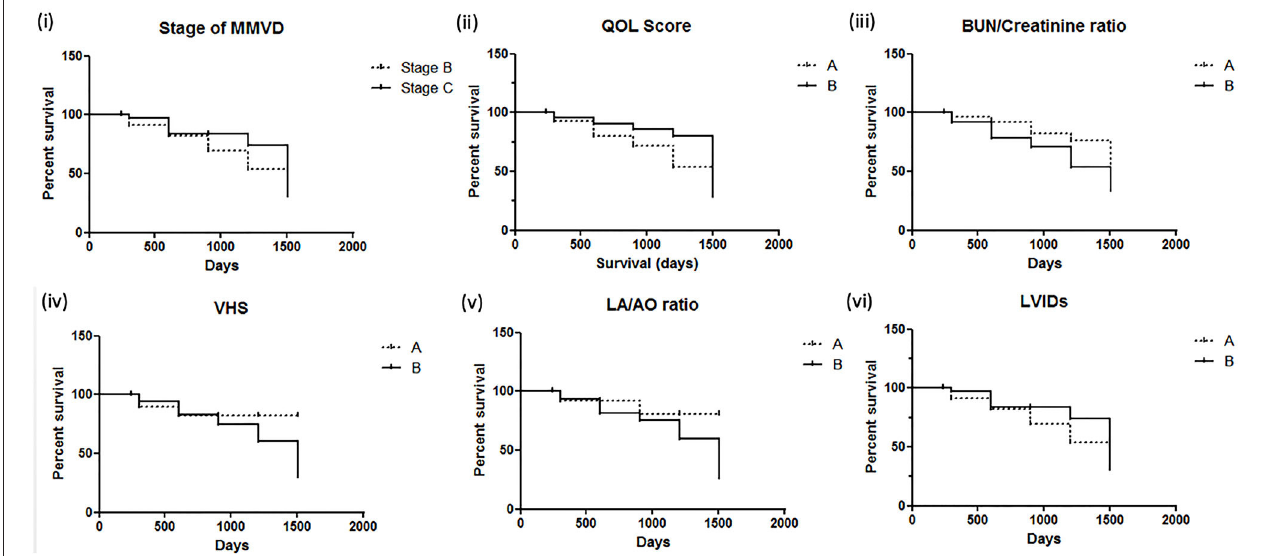
FIGURE 5 | Kaplan–Meier survival curves for dogs with mitral valve degeneration. (i) Stage of MMVD (myxomatous mitral valve degeneration); (ii) QOL score, quality of life score (A = QOL score < 3, B = QOL score > 3); (iii) BUN/creatinine ratio (A = BUN/creatinine < 20, B = BUN/creatinine > 20); (iv) VHS, vertebral heart score (A = VHS < 10.5, B = VHS > 10.5); (v) LA/AO ratio, left atrium/aorta ratio (A = LA/AO < 1.60, B = LA/AO > 1.60); (vi) LVIDs, left ventricular internal diameter during systole (A = LVIDs < 2.0, B = LVIDs > 2.0). Group A included dogs with normal right ventricular function, and group B included dogs with impaired right ventricular function.